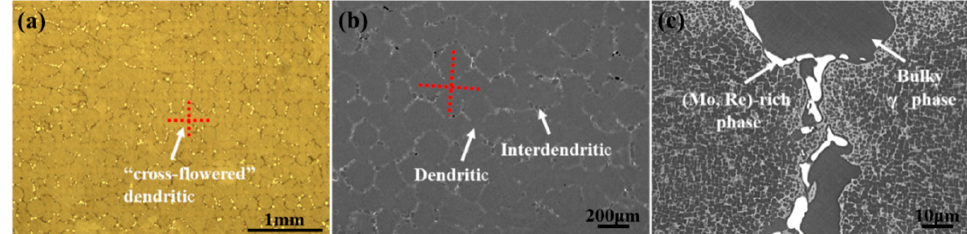
Figure 1. The microstructure of as-cast experimental alloy: ( a ) OM image of dendritic structure; ( b ) SEM of dendritic structure; ( c ) interdendritic region of ( b ). The SEM secondary electrons (SE) morphology of γ (cid:48) reprecipitation after